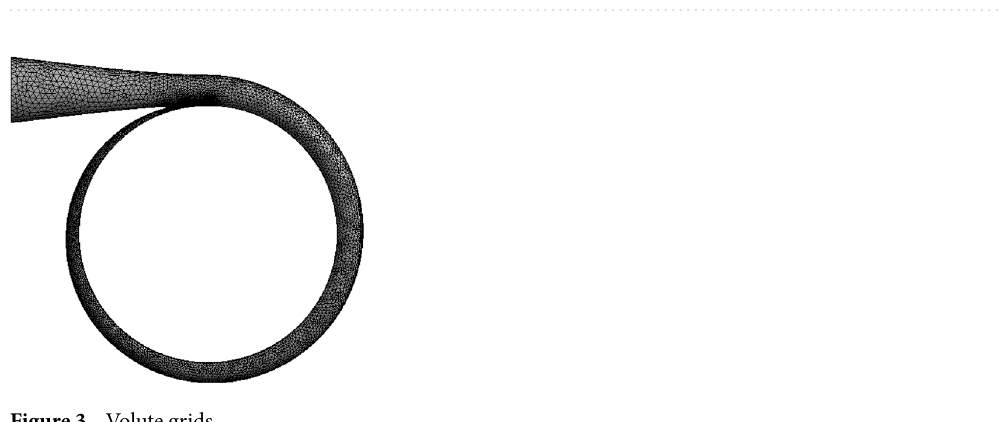
Figure 3. Volute